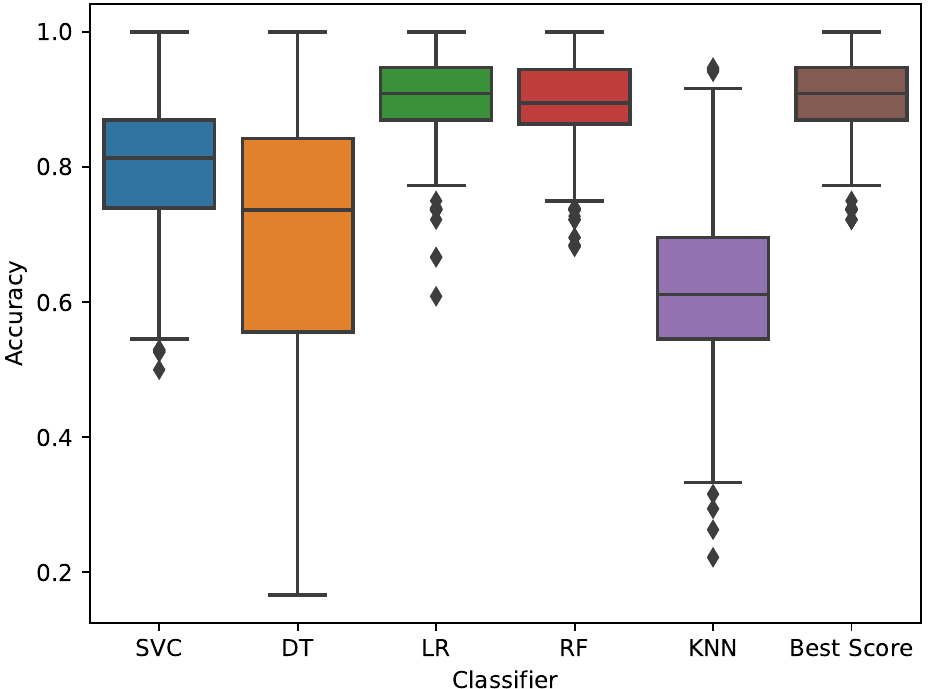
Figure 4. The accuracies of each algorithm for all the users. The last box plot provides the scores obtained from the best algorithm for each